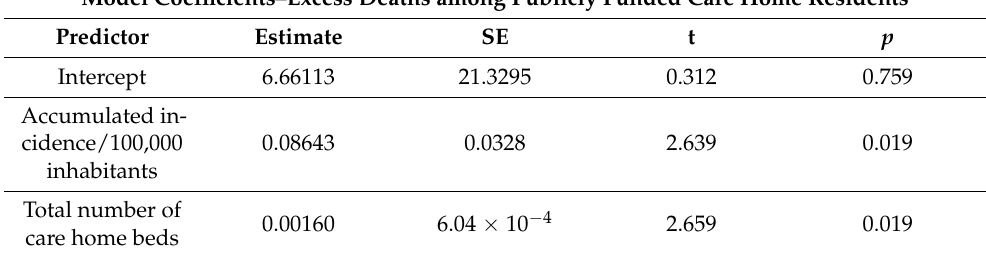
Table 3. Linear regression model after eliminating non-significant independent variables.